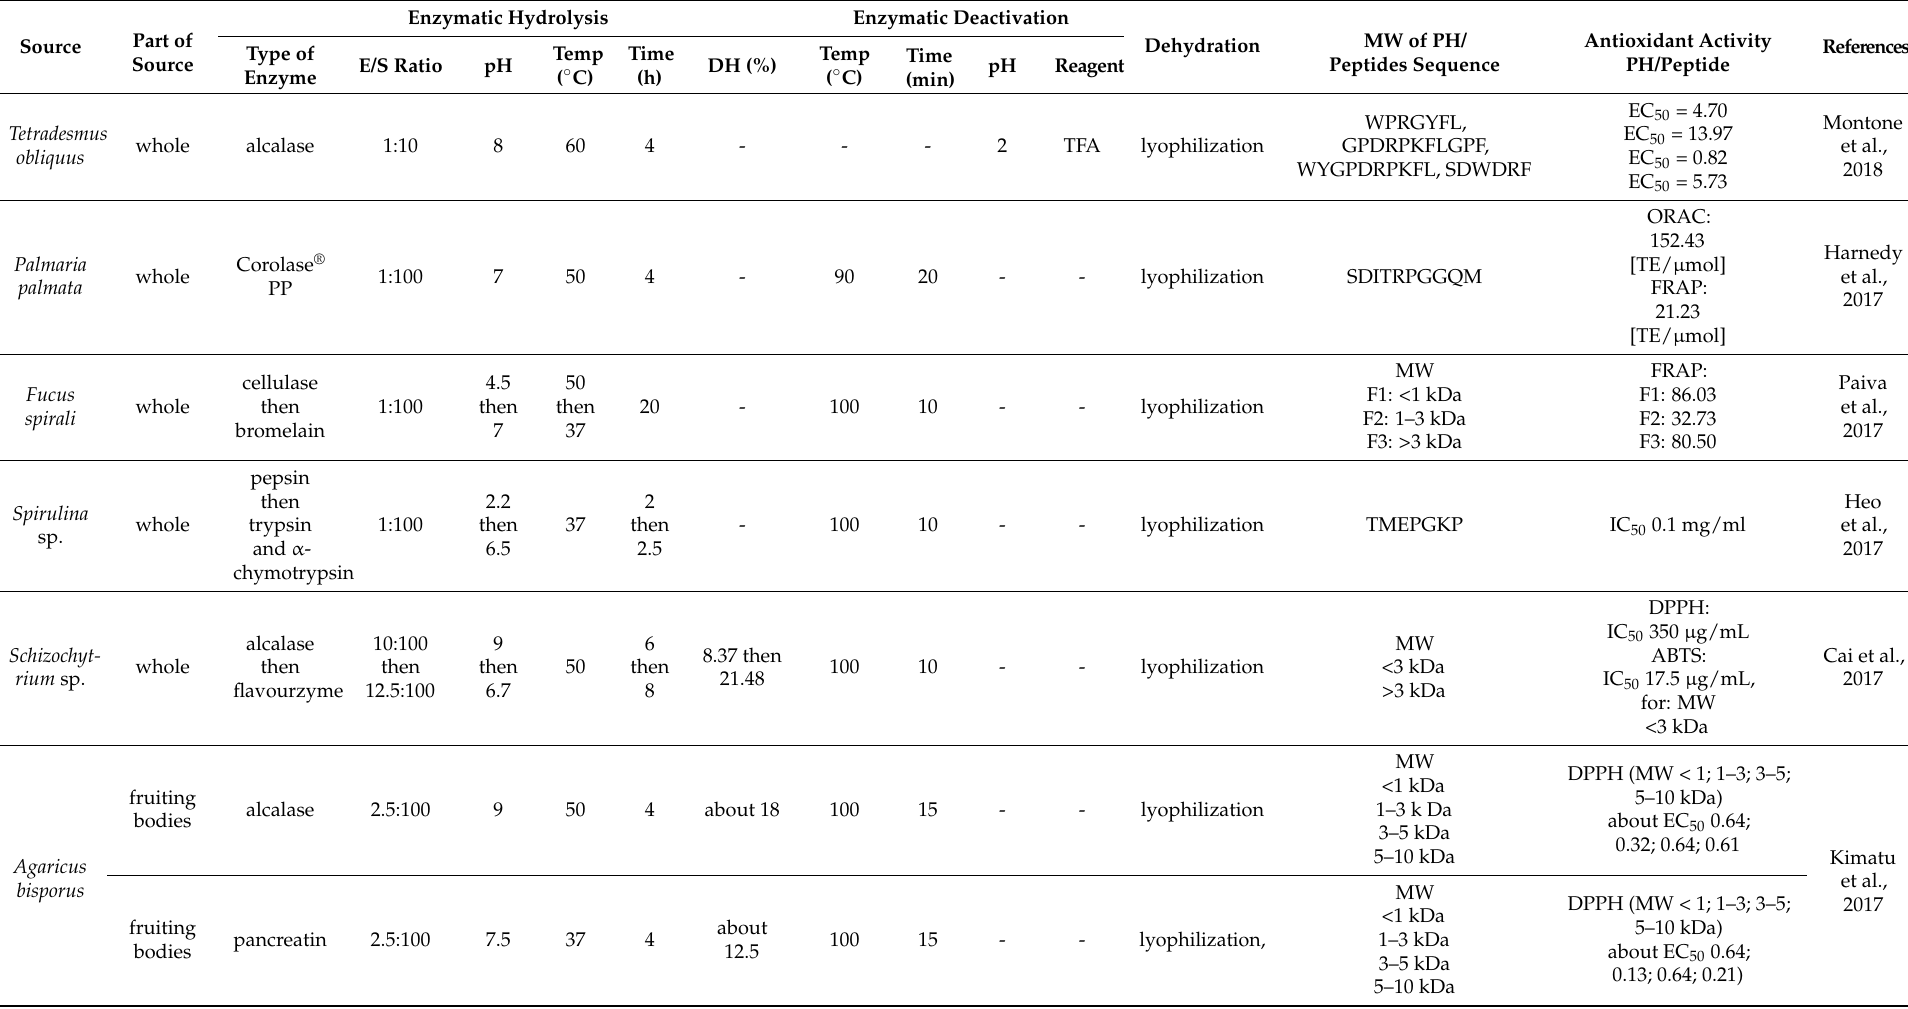
Table 2. Methods of obtaining protein hydrolysates of plant